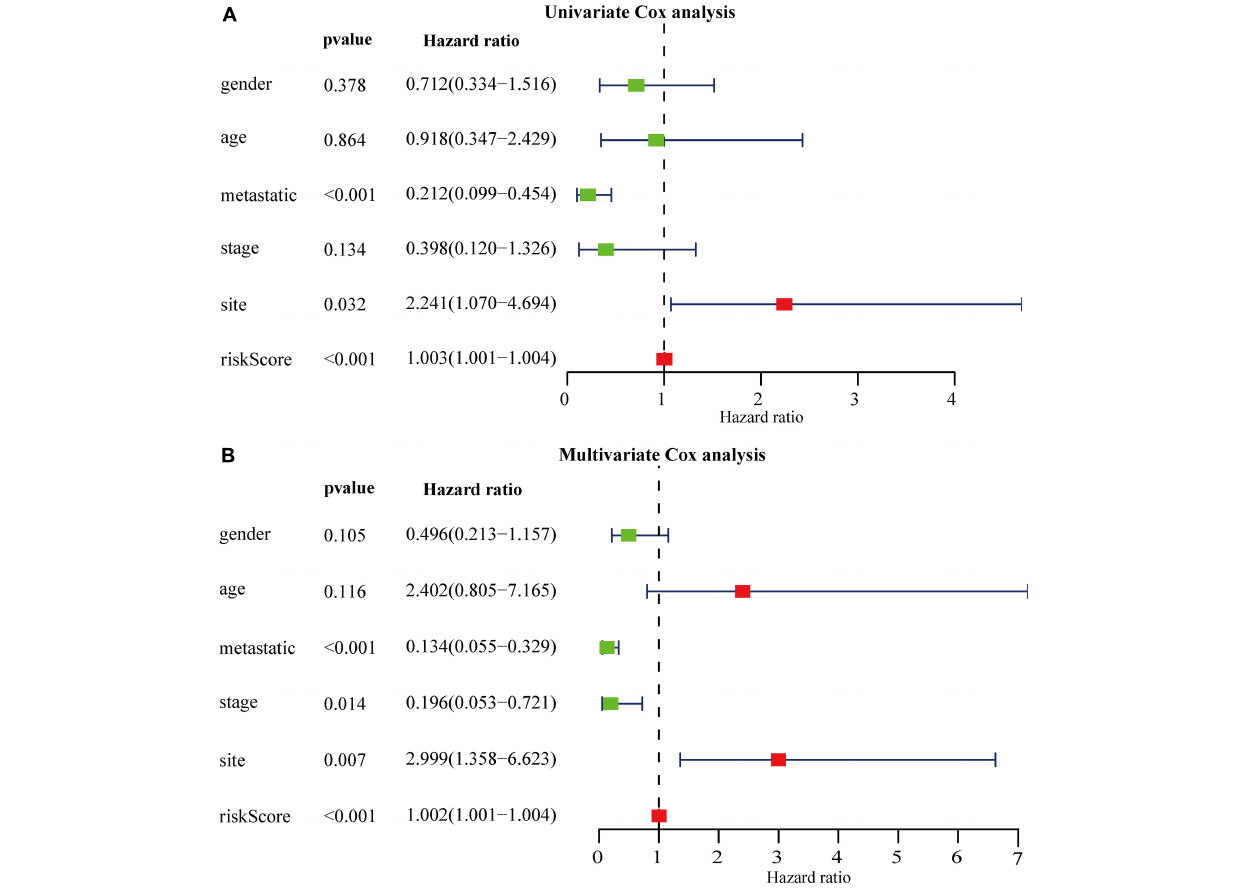
FIGURE 8 | Relationship between autophagy-related lncRNA signature expression, clinicopathological characteristics, and osteosarcoma patient prognosis. (A,B) Forest plot showing the results of (A) univariate Cox regression analyses and (B) multivariate Cox regression